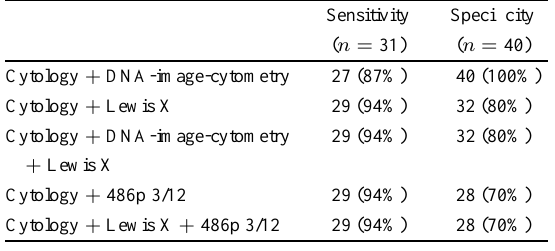
Improvement of detection of bladder cancer in 71 patients by com- bination of cytology, DNA-image-cytometry and immunocytology